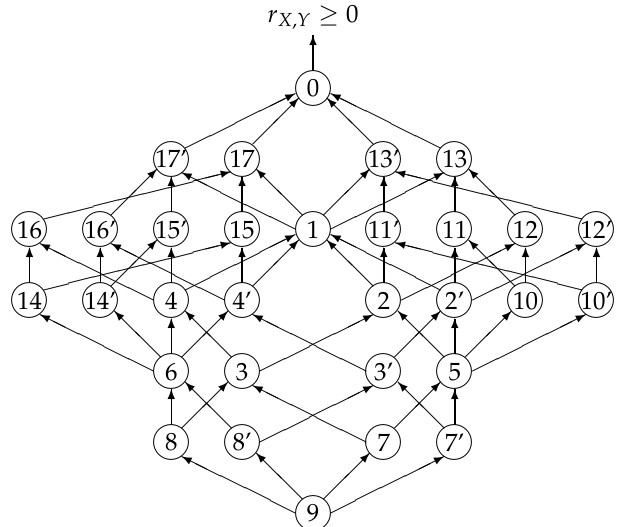
Figure 2. Relationships among the positive dependence notions in Table